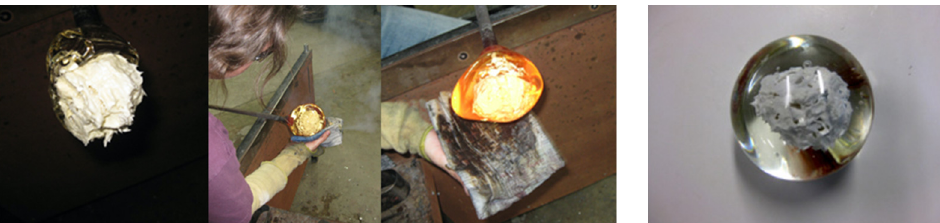
Figure 2. Jessamy Kelly and Criss Chaney; 2009; blown glass paperweight with compatible pre-fired bone china core inclusion; photo credit: the artist, used with permission.